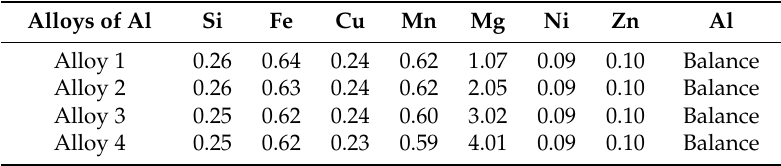
Table 2. Chemical composition of the alloys prepared for studying the aluminothermic reduction of Mn 2 O 3 powders (wt